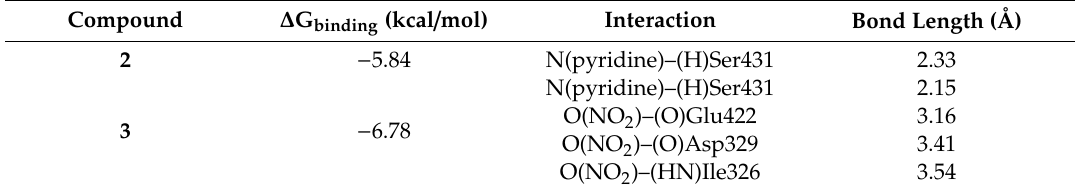
Table 2. Docking results against the homology model of the Fophy protein.